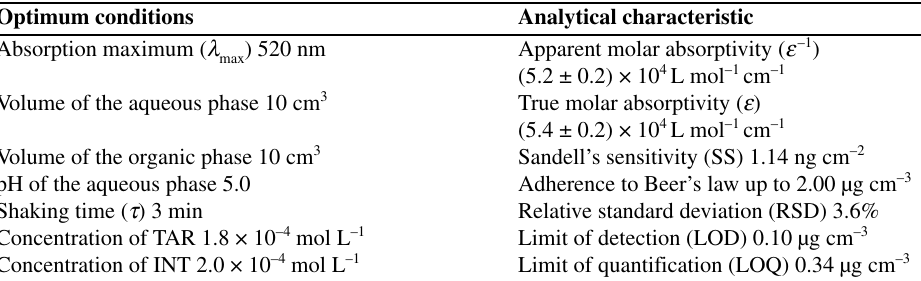
Table 1. Optimum extraction-spectrophotometric conditions and analytical characteristics of the system